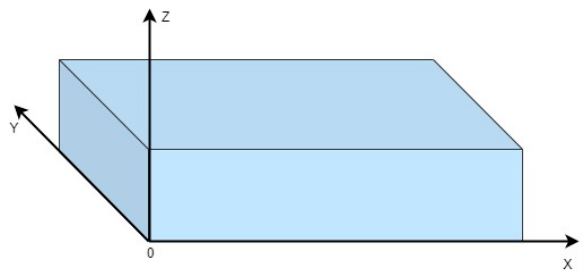
Figure 8. Outline of the monitoring area.